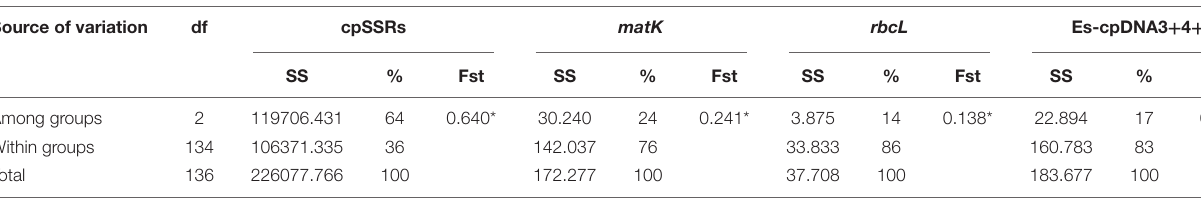
FIGURE 2 | Haplotype network and the phylogenetic tree constructed based on cpDNA datasets. TABLE 4 | AMOVA analysis inferred by cpDNA and